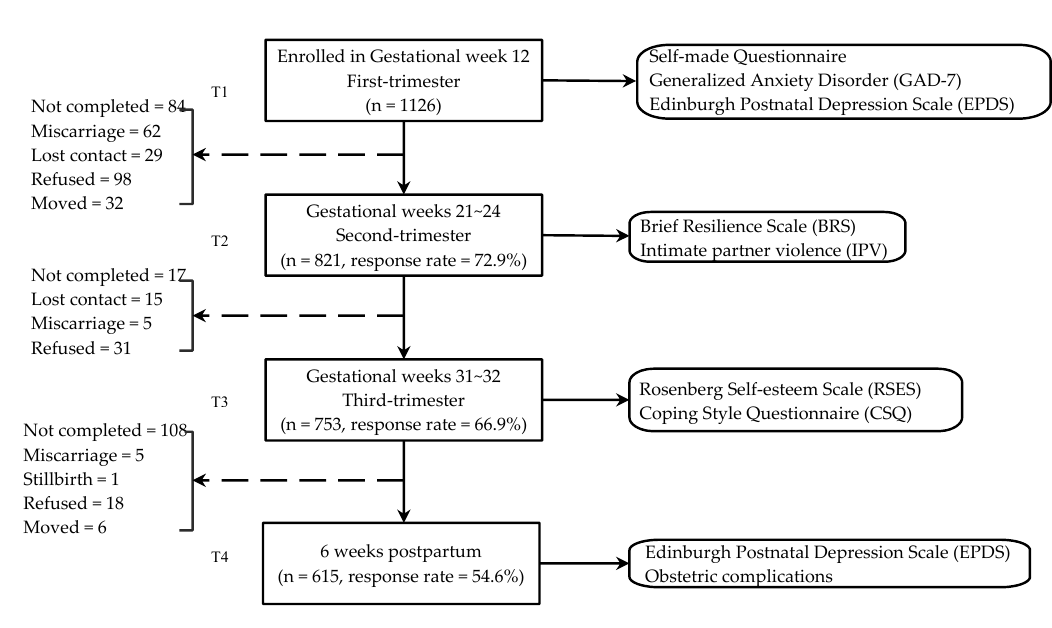
Figure 1. Flow of participants through the study.